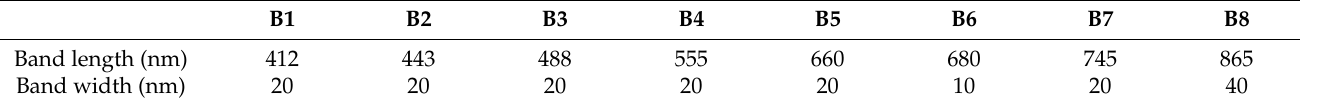
Table 2. GOCI satellite band parameter information.